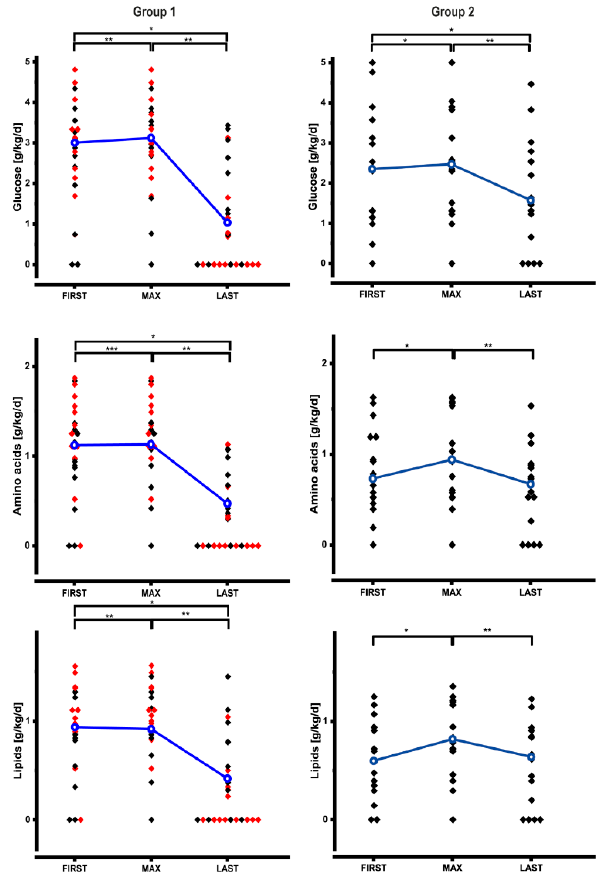
Figure A2: Dynamic changes of amino acids, lipids, and glucose support in group 1 and group 2 patients. In group 1, 11 patients had reconstructive surgery and 2 patients received teduglutide